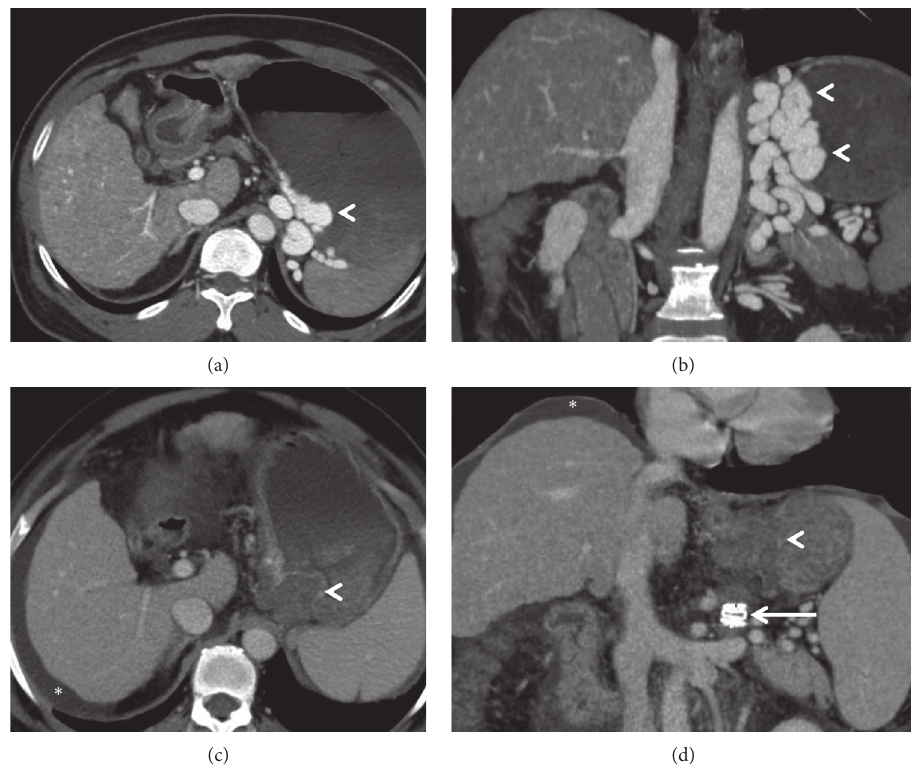
Figure 9: Axial (a, c) and coronal (b, d) CECTimages depicting gastric varices (arrowheads in (a, b)) associated with a gastrorenal shunt in a 58-year-old patient with liver cirrhosis and intractable gastric variceal bleeding. The patient underwent plug-assisted retrograde transvenous obliteration (PARTO) of the shunt and variceal complex. Postprocedure images (c, d) show completely thrombosed varices (arrowheads) with vascular plug-in-situ (arrow). Note. The interval appearance of mild ascites (asterisk) after the procedure which responded to